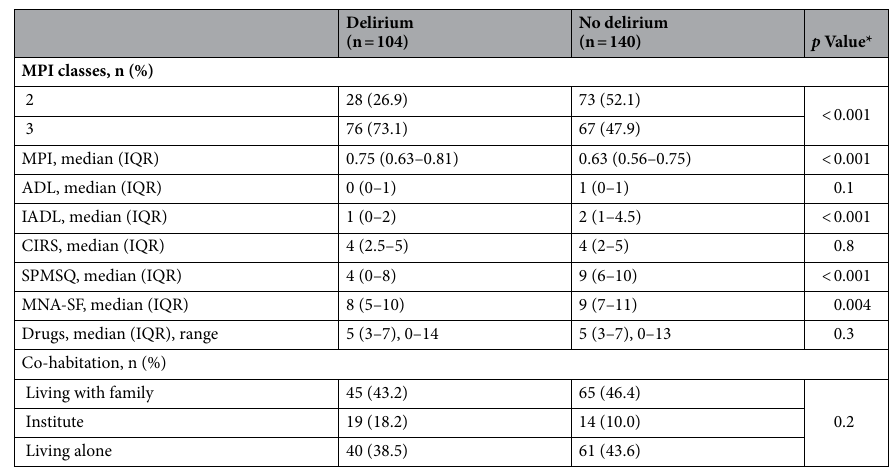
Table 2. MPI score and other subdomains according to diagnosis of delirium. Mean values of Exton Smith Scale are not available; * p value for Mann–Whitney test or Fisher exact test. IQR interquartile range, ADL activities of daily living, CIRS cumulative illness rating scale, IADL instrumental activities of daily living, IQR interquartile range, MNA-SF mini nutritional assessment short form, MPI multidimensional prognostic index, SD standard deviation, SPMSQ short portable mental status questionnaire.